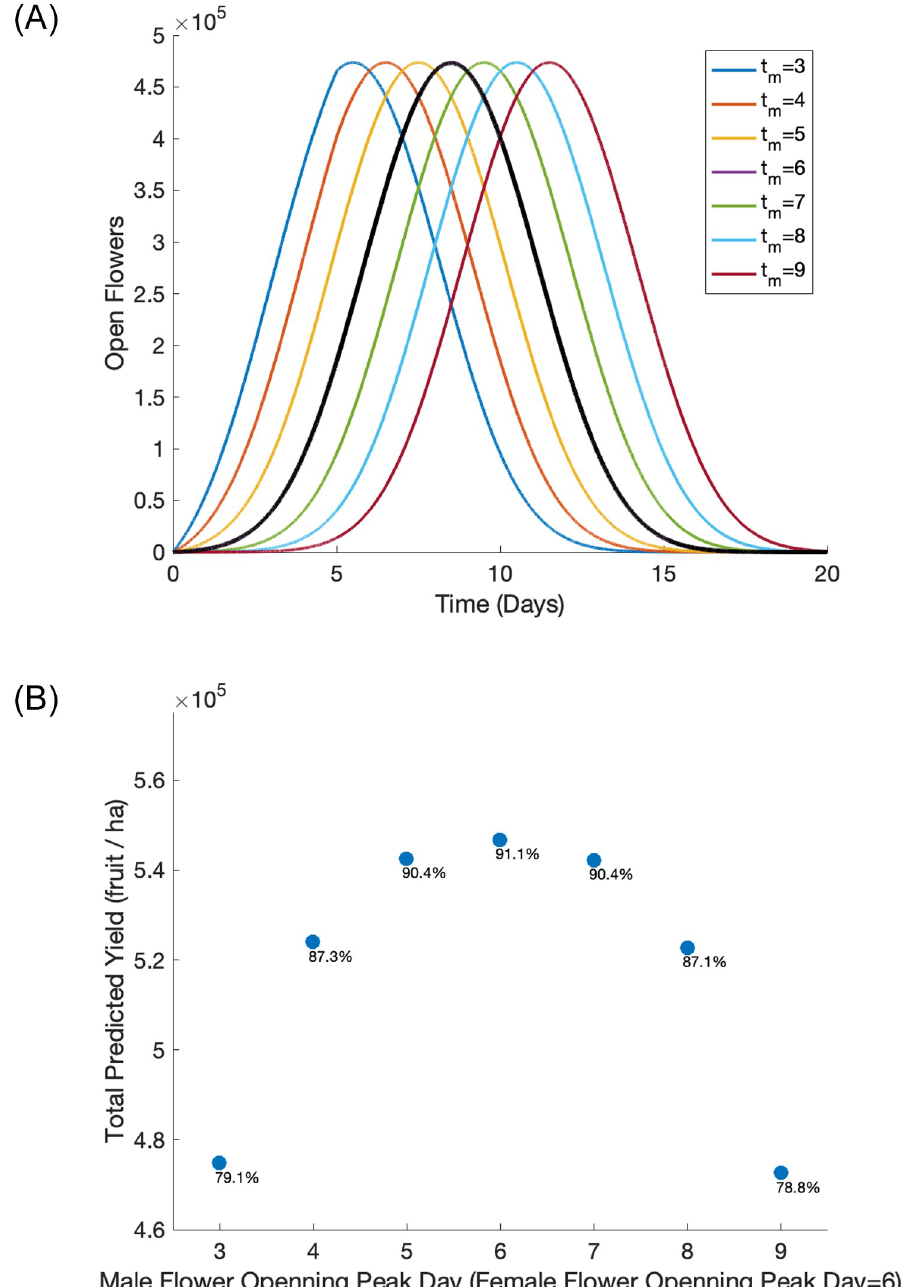
Fig 6. Open male (colored) and female (black) flowers (a) and total predicted yield (b) for varying peak day of male flower opening from day 3 to day 9. The total amount of buds was kept constant at 1.2 million/ha with a male to female flower ratio of 1:1 and 6 bees per 1000 female flowers. Other parameters are baseline values in Table 2. The percentage of open female flowers that achieved sufficient pollination to set fruit is listed under each data point. Parameter sensitivity analysis shows that the percentage of female flowers, the total number of buds, and the bee density have the most significant effect on the total predicted yield (Fig 10) with a positive correlation. Bee density, the pollinators’ preference to switch from female to male flowers ( � ), the male flowering period ( σ ), and the pollinator’s preference to switch m